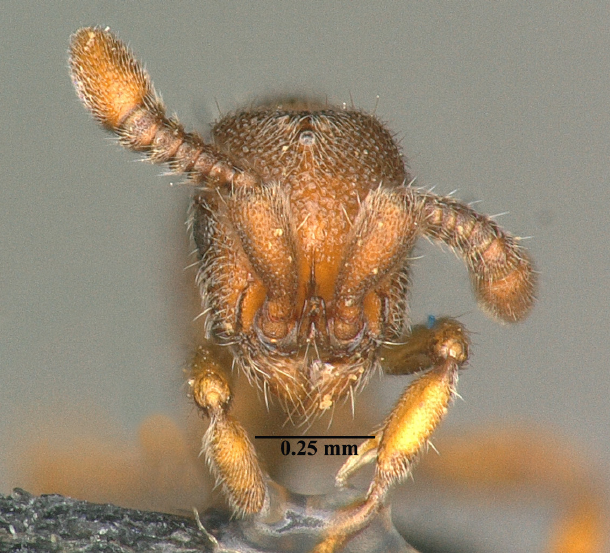
Fig 5 . Ooceraea octoantenna Zhou & Chen sp. nov., paratype queen, head in full-face